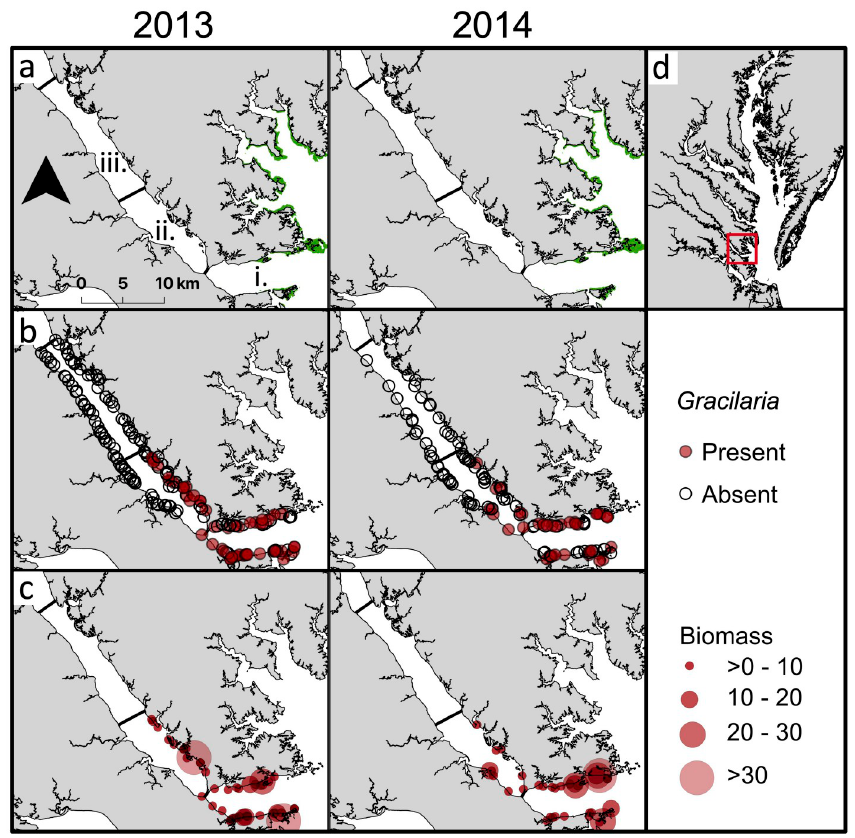
Fig 1. Map of York River (a) seagrass beds (green) in 2013 (left) [65] and 2014 (right) [66] and sampling regions at downriver (i), midriver (ii), and upriver (iii) sections along the river axis; (b) locations of all sites where Gracilaria vermiculophylla was present (filled) or absent (open) in 2013 (left) and 2014 (right); (c) G. vermiculophylla biomass (g dry weight m − 2 ) at locations where it was present in 2013 (left) and 2014 (right); and (d) location of York River, a western shore tributary of Chesapeake